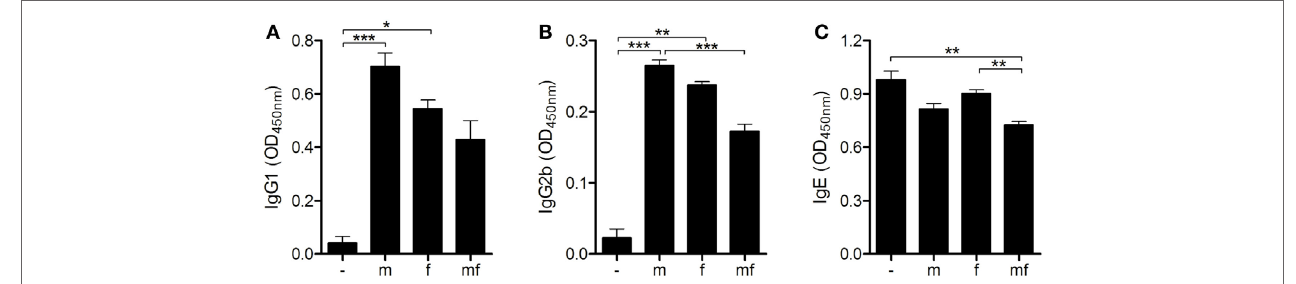
FigUre 3 | Male schistosomes increase the production of protective IgG1 and IgG2b antibodies. Six weeks p.i., (a) IgG1, (B) IgG2b, and (c) immunoglobulin E (IgE) serum levels of Schistosoma mansoni -infected mice were quantified by ELISA. Data are represented as mean + SEM; n = 5 or 10 mice each group; * p < 0.05, ** p < 0.01, *** p <